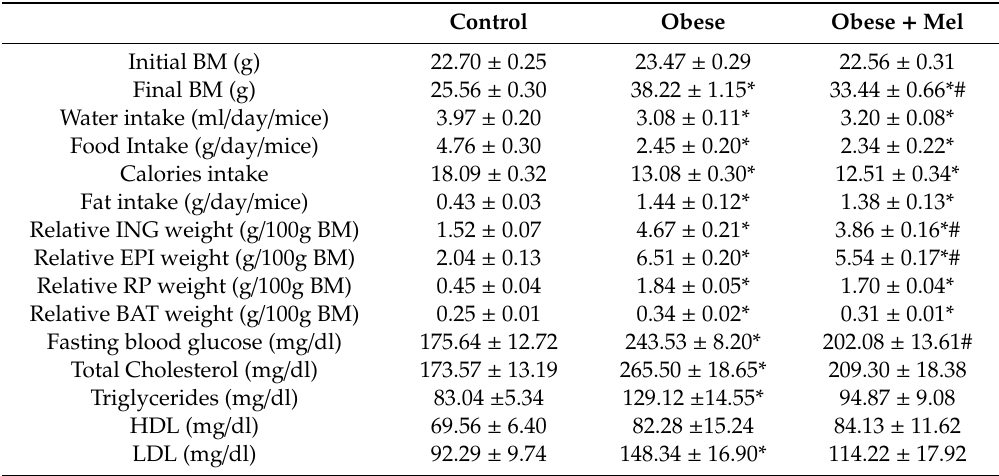
Table 1. Body mass (BM), food intake, organ weights and blood biochemical parameters after 10 weeks of a high-fat diet feeding and melatonin suplementation in